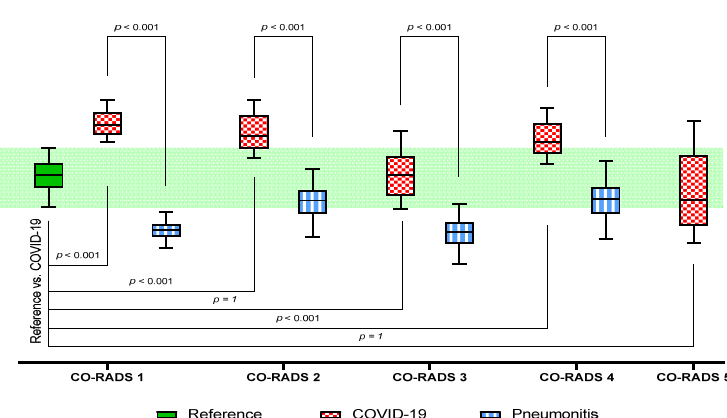
Figure 3. Averaged DECT metrics per Pulmonary Lobe.